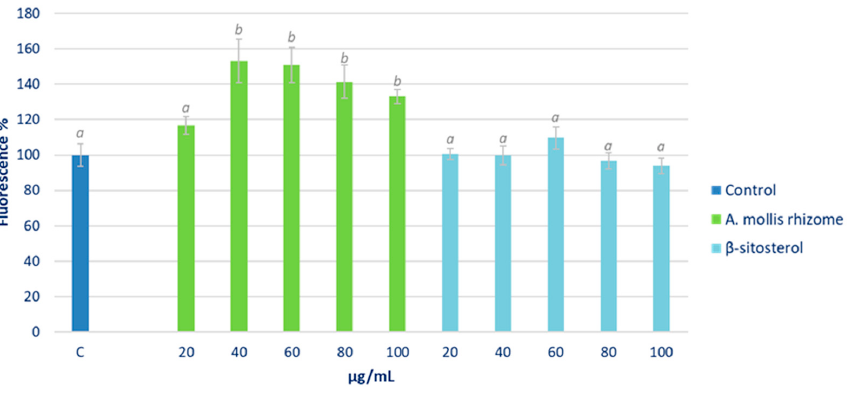
Figure 4. Effect of different concentrations of Acanthus rhizome extract and β -sitosterol on ROS levels in a HepG2 cell culture growing under normal culture conditions. Cells were treated with 0 (control, C), 20, 40, 60, 80, and 100 µg/mL of extract or reference substance for 90 min. Different letters indicate significant differences (ANOVA-Test, Bonferroni p < 0.05).